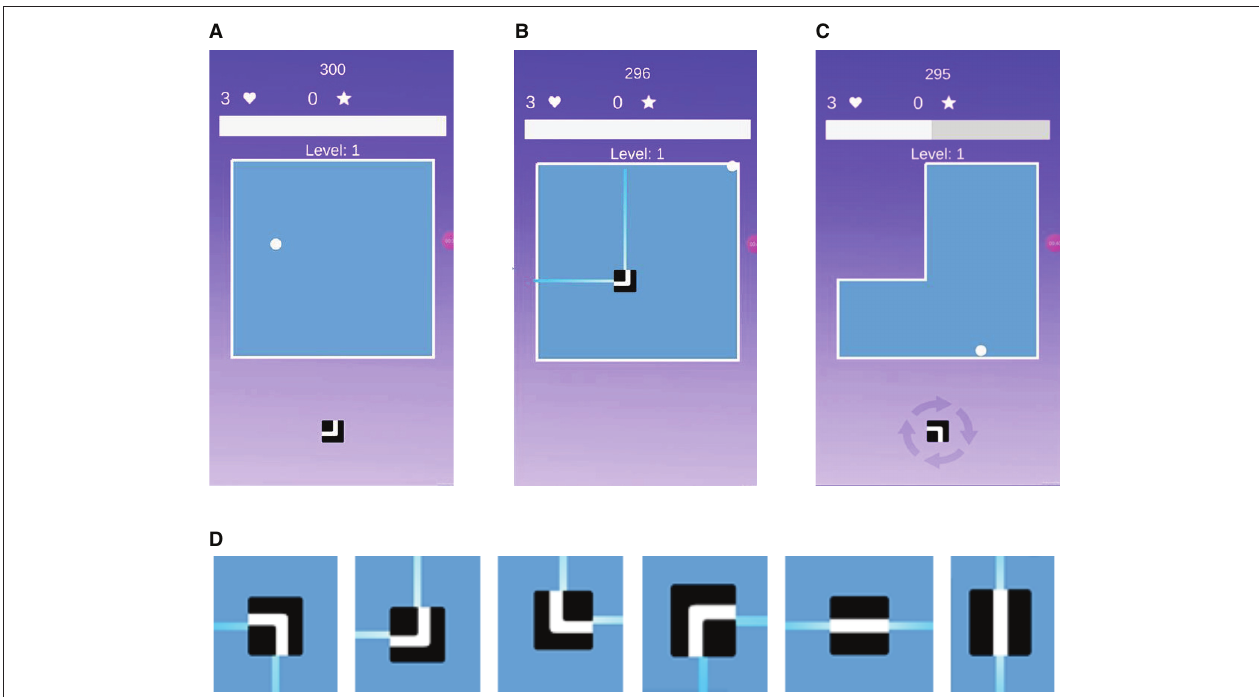
FIGURE 1 | Screen shots of the casual game (scale). (A) A square arena is initially presented to the user. (B) Upon placing the tile in the arena. (C) The arena gets cropped. (D) Illustration of the six tiles available in the game, and their respective cropping actions. integrated with a breathing guide. As illustrated in Figures 1A–C , is bouncing with a randomly initialized direction and